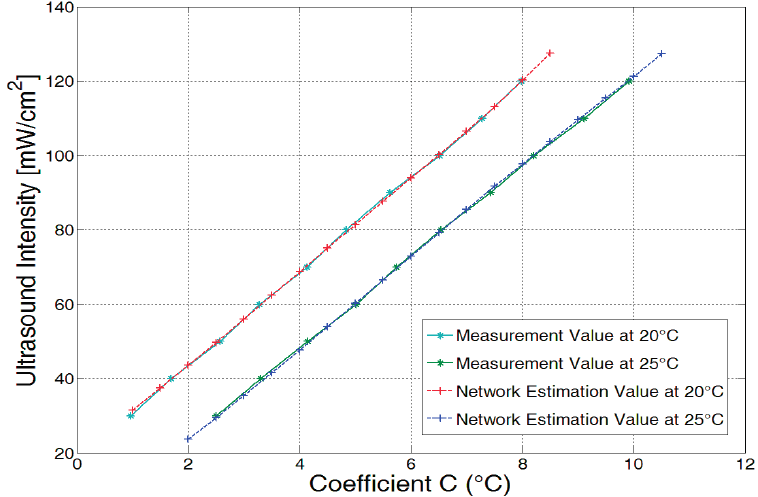
Figure 11. Comparison between the estimated data sets and the real measurement data